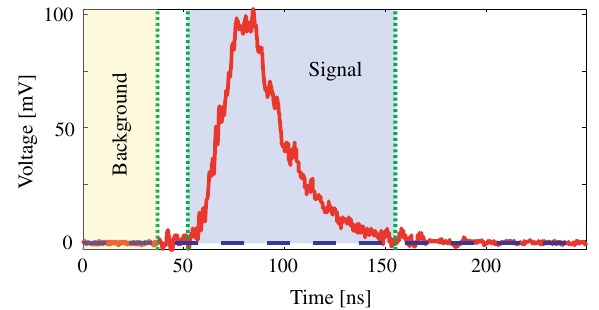
FIG. 3. Typical measured ICT signal (solid line). The back- ground level was evaluated by averaging the signal between 0 ns and the first vertical dotted line, and is shown by the dashed line. To obtain charge, the signal between the second and the third vertical dotted line was